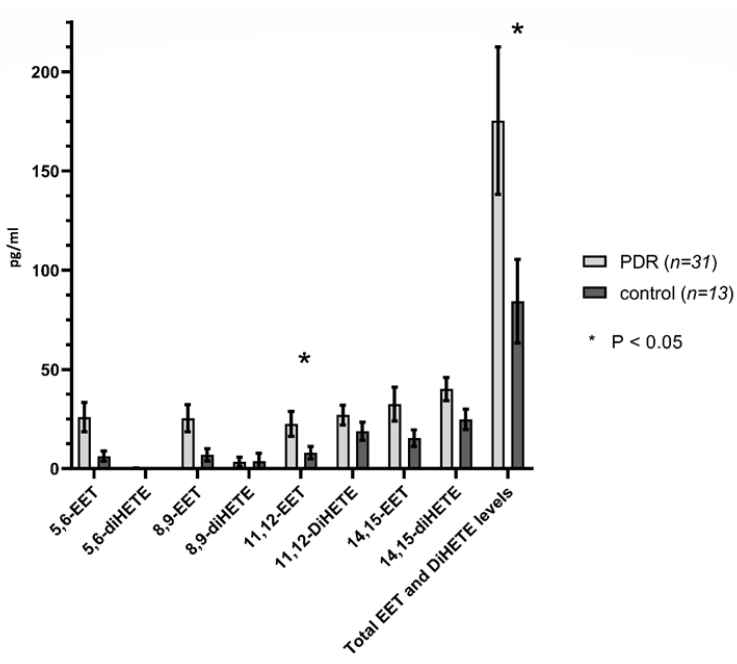
Figure 3. Human vitreous levels of eicosanoids in PDR ( n = 31) vs. control ( n = 13) eyes. Comparison of levels (pg/mL) of individual EET and DiHETE, as well as total levels in PDR vs. controls. * denotes statistical significance ( p < 0.05).